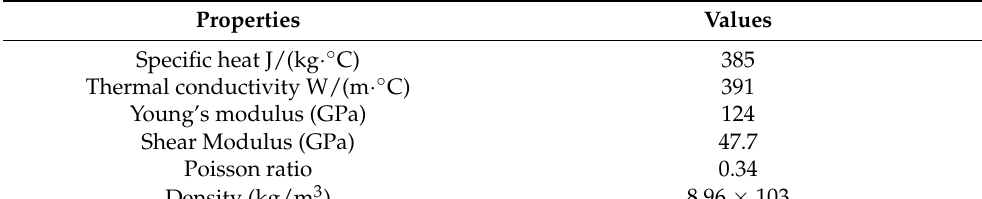
Figure 6. SEM images of carbide micromilling cutter. ( a ) Rake face; ( b ) Bottom face. Table 2. Physical properties of OFC-TU1 material.